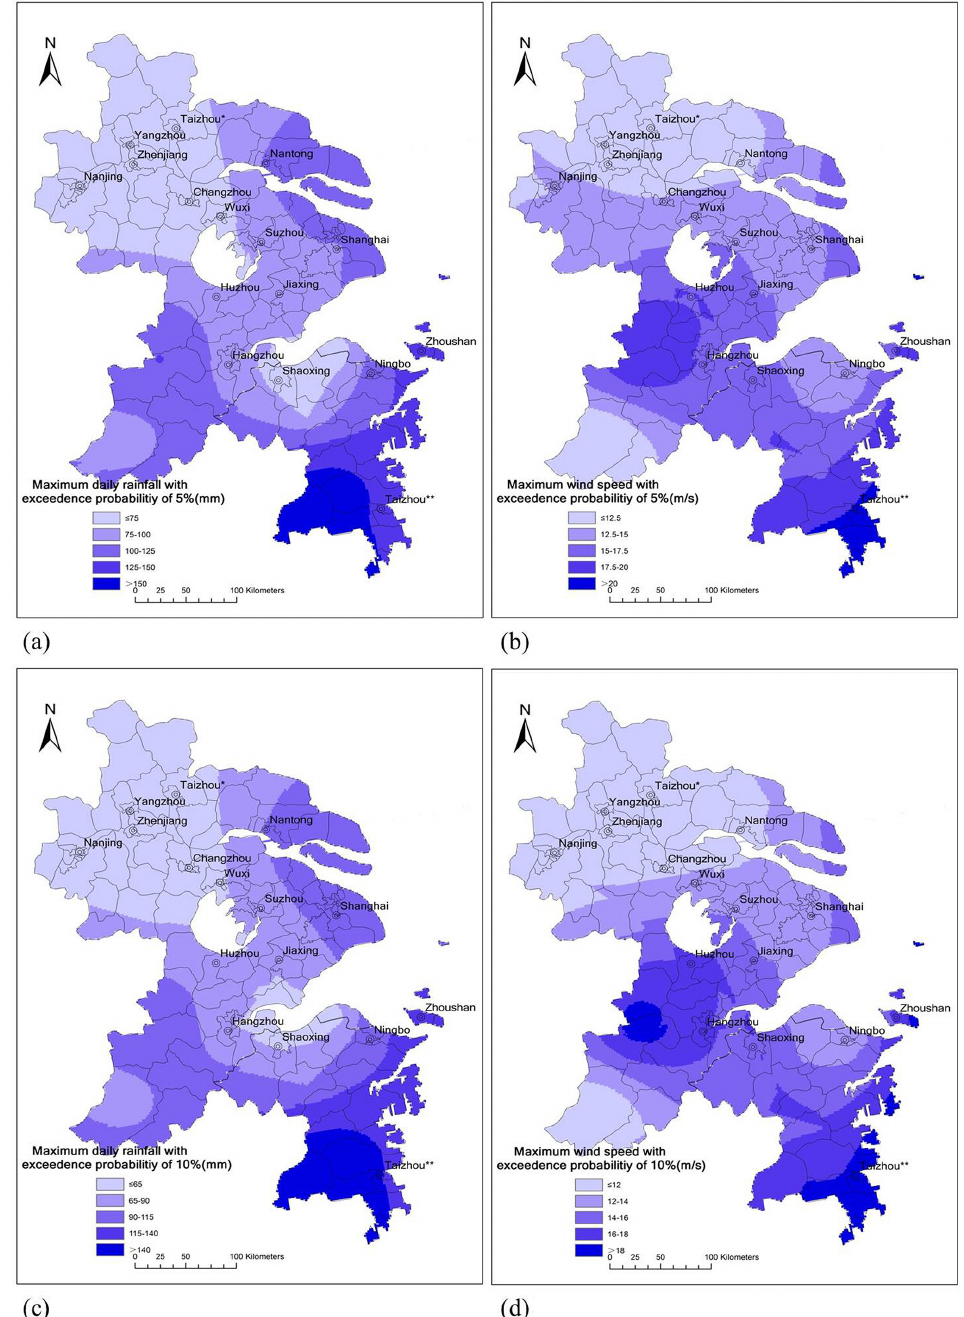
Figure 5. Distribution of maximum daily rainfall and maximum wind speed during typhoon with different exceedance probabilities. (a) Max- imum daily rainfall distribution with exceedance probability of 5%. (b) Maximum wind speed distribution with exceedance probability of 5%. (c) Maximum daily rainfall distribution with exceedance probability of 10%. (d) Maximum wind speed distribution with exceedance probability of